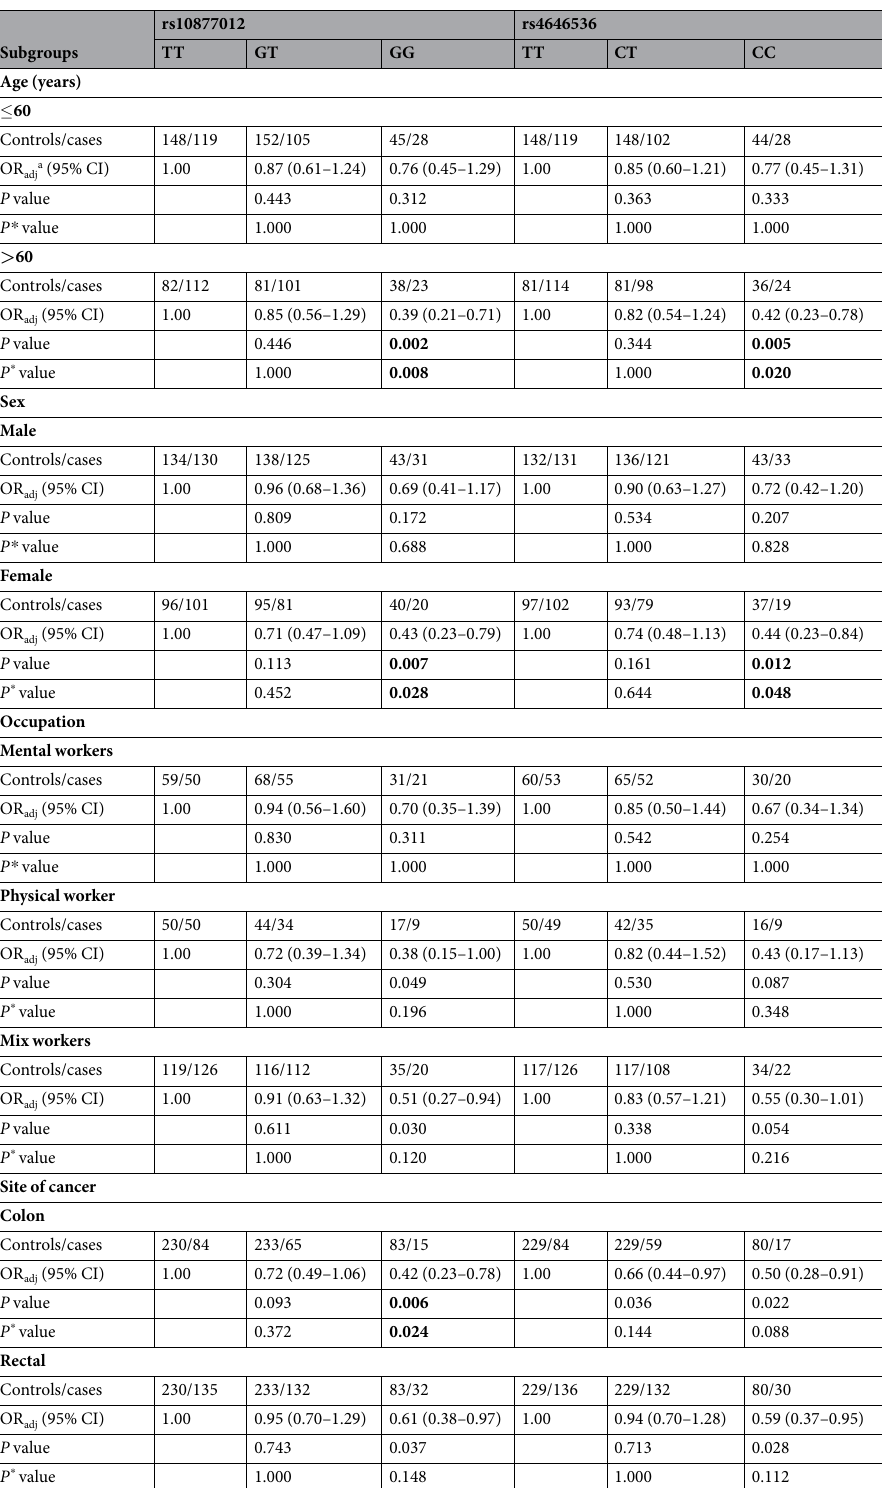
Table 3. Subgroup analyses for the associations between rs10877012, rs4646536 in CYP27B1 and the risk of colorectal cancer. Non-mental workers include physical workers and mixed workers. Note: No